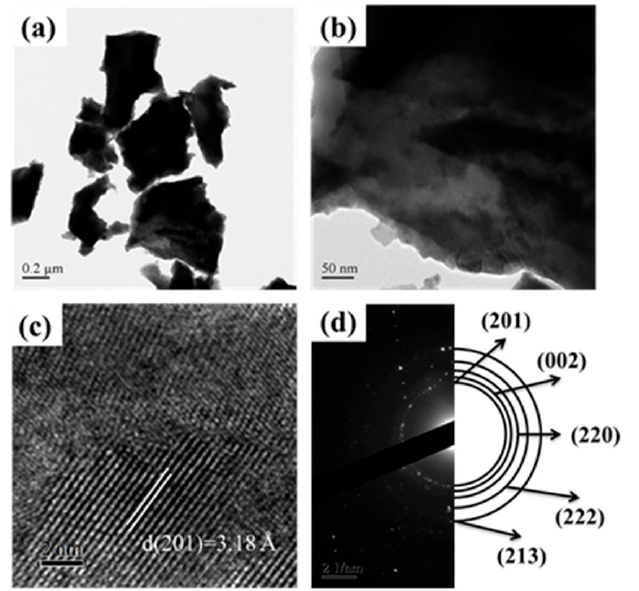
Figure 4. The TEM image for Bi/Hf (90/10) sintered at 700 °C ( a ) low magnification TEM ( b ) high magnification TEM ( c ) d-spacing in HRTEM (high resolution transmission electron microscopy) ( d ) SAED (selected area electron diffraction).